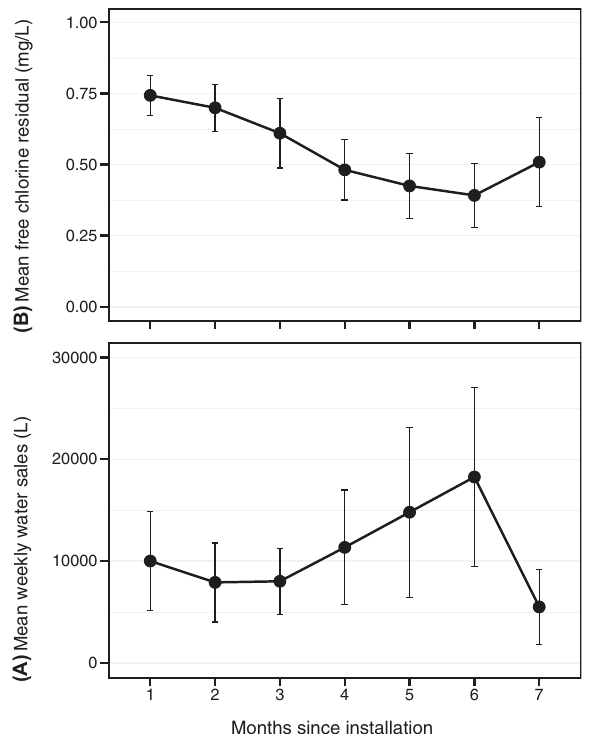
Fig. 3 Water sales (L) and free chlorine residual (mg/L) at all kiosks by month since installation. A Mean weekly water sales (L) at all kiosks by month since installation of the device. B Mean free chlorine residual (mg/L) in water collected from Venturi at all kiosks by month since installation of the device. Error bars show 95% con fi dence intervals. The non-dosing problem at Kiosk F began occurring after 3 months of installation and a new device was installed 6 months after the original installation. Data are aggregated by months since original